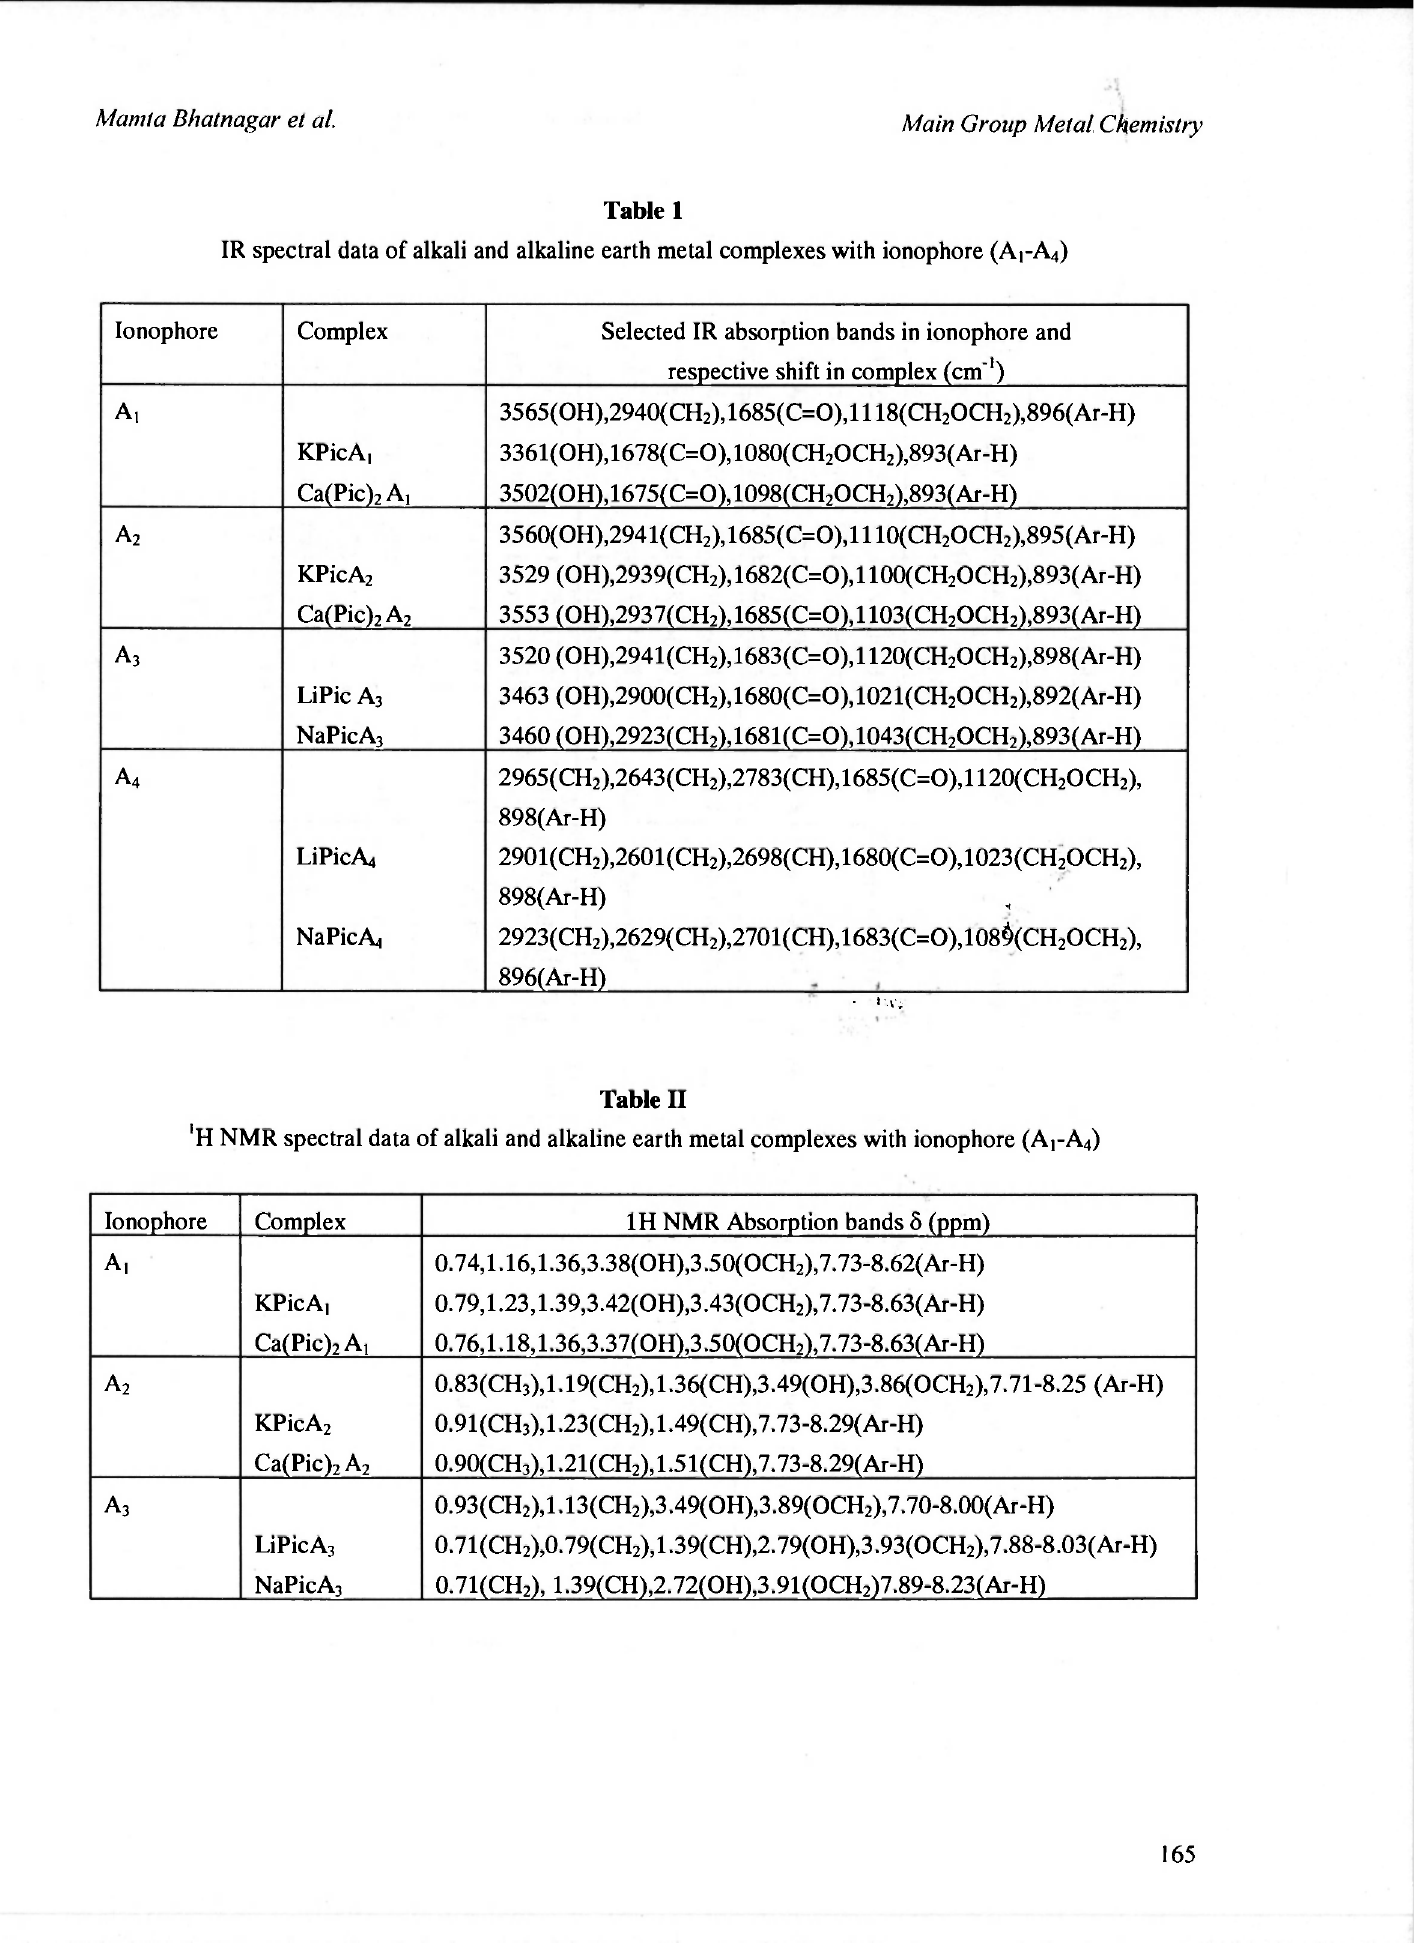
'H NMR spectral data of alkali and alkaline earth metal complexes with ionophore (A r A 4